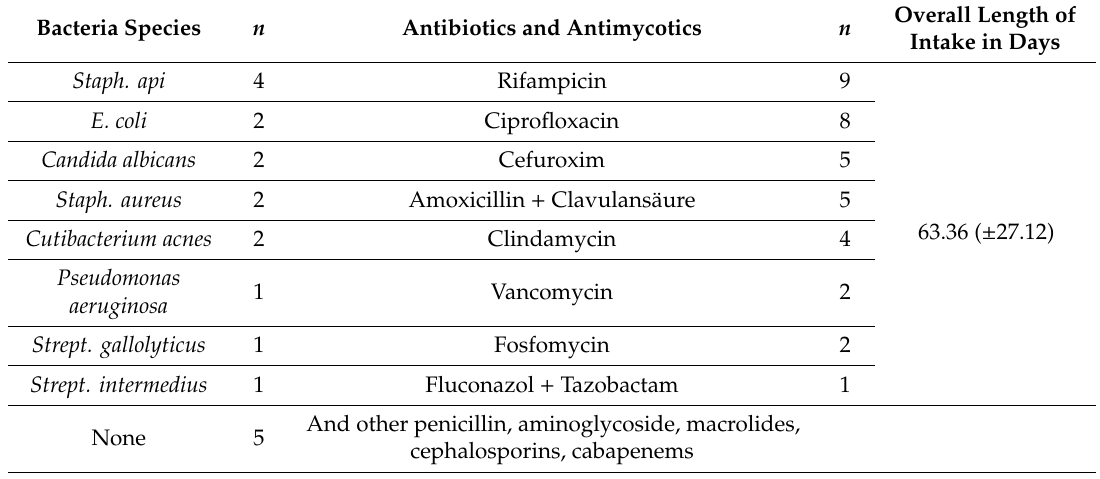
Table 3. Bacteria species detected in tissue samples and antibiotic therapy.